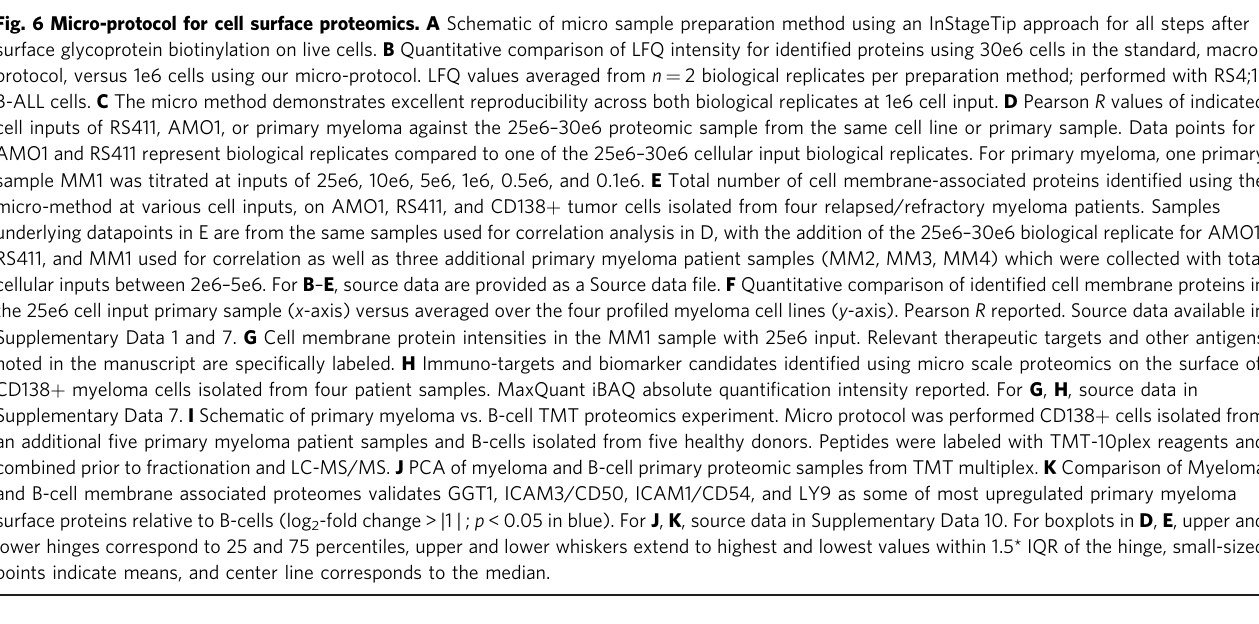
Fig. 6 Micro-protocol for cell surface proteomics. A Schematic of micro sample preparation method using an InStageTip approach for all steps after surface glycoprotein biotinylation on live cells. B Quantitative comparison of LFQ intensity for identi fi ed proteins using 30e6 cells in the standard, macro- protocol, versus 1e6 cells using our micro-protocol. LFQ values averaged from n = 2 biological replicates per preparation method; performed with RS4;11 B-ALL cells. C The micro method demonstrates excellent reproducibility across both biological replicates at 1e6 cell input. D Pearson R values of indicated cell inputs of RS411, AMO1, or primary myeloma against the 25e6 – 30e6 proteomic sample from the same cell line or primary sample. Data points for AMO1 and RS411 represent biological replicates compared to one of the 25e6 – 30e6 cellular input biological replicates. For primary myeloma, one primary sample MM1 was titrated at inputs of 25e6, 10e6, 5e6, 1e6, 0.5e6, and 0.1e6. E Total number of cell membrane-associated proteins identi fi ed using the micro-method at various cell inputs, on AMO1, RS411, and CD138 + tumor cells isolated from four relapsed/refractory myeloma patients. Samples underlying datapoints in E are from the same samples used for correlation analysis in D, with the addition of the 25e6 – 30e6 biological replicate for AMO1, RS411, and MM1 used for correlation as well as three additional primary myeloma patient samples (MM2, MM3, MM4) which were collected with total cellular inputs between 2e6 – 5e6. For B – E , source data are provided as a Source data fi le. F Quantitative comparison of identi fi ed cell membrane proteins in the 25e6 cell input primary sample ( x -axis) versus averaged over the four pro fi led myeloma cell lines ( y -axis). Pearson R reported. Source data available in Supplementary Data 1 and 7. G Cell membrane protein intensities in the MM1 sample with 25e6 input. Relevant therapeutic targets and other antigens noted in the manuscript are speci fi cally labeled. H Immuno-targets and biomarker candidates identi fi ed using micro scale proteomics on the surface of CD138 + myeloma cells isolated from four patient samples. MaxQuant iBAQ absolute quanti fi cation intensity reported. For G , H , source data in Supplementary Data 7. I Schematic of primary myeloma vs. B-cell TMT proteomics experiment. Micro protocol was performed CD138 + cells isolated from an additional fi ve primary myeloma patient samples and B-cells isolated from fi ve healthy donors. Peptides were labeled with TMT-10plex reagents and combined prior to fractionation and LC-MS/MS. J PCA of myeloma and B-cell primary proteomic samples from TMT multiplex. K Comparison of Myeloma and B-cell membrane associated proteomes validates GGT1, ICAM3/CD50, ICAM1/CD54, and LY9 as some of most upregulated primary myeloma surface proteins relative to B-cells (log 2 -fold change > |1 | ; p < 0.05 in blue). For J , K , source data in Supplementary Data 10. For boxplots in D , E , upper and lower hinges correspond to 25 and 75 percentiles, upper and lower whiskers extend to highest and lowest values within 1.5* IQR of the hinge, small-sized points indicate means, and center line corresponds to the